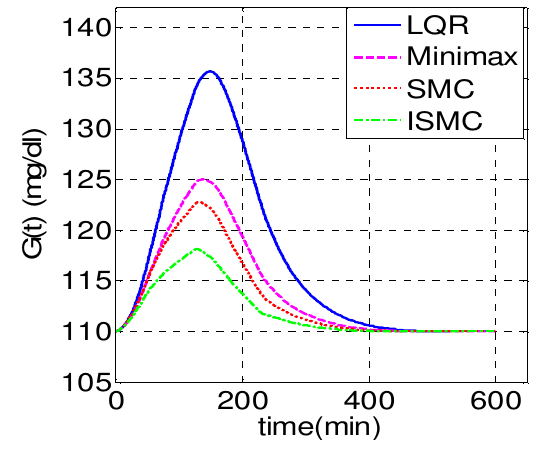
Fig. 5. Plasma glucose level